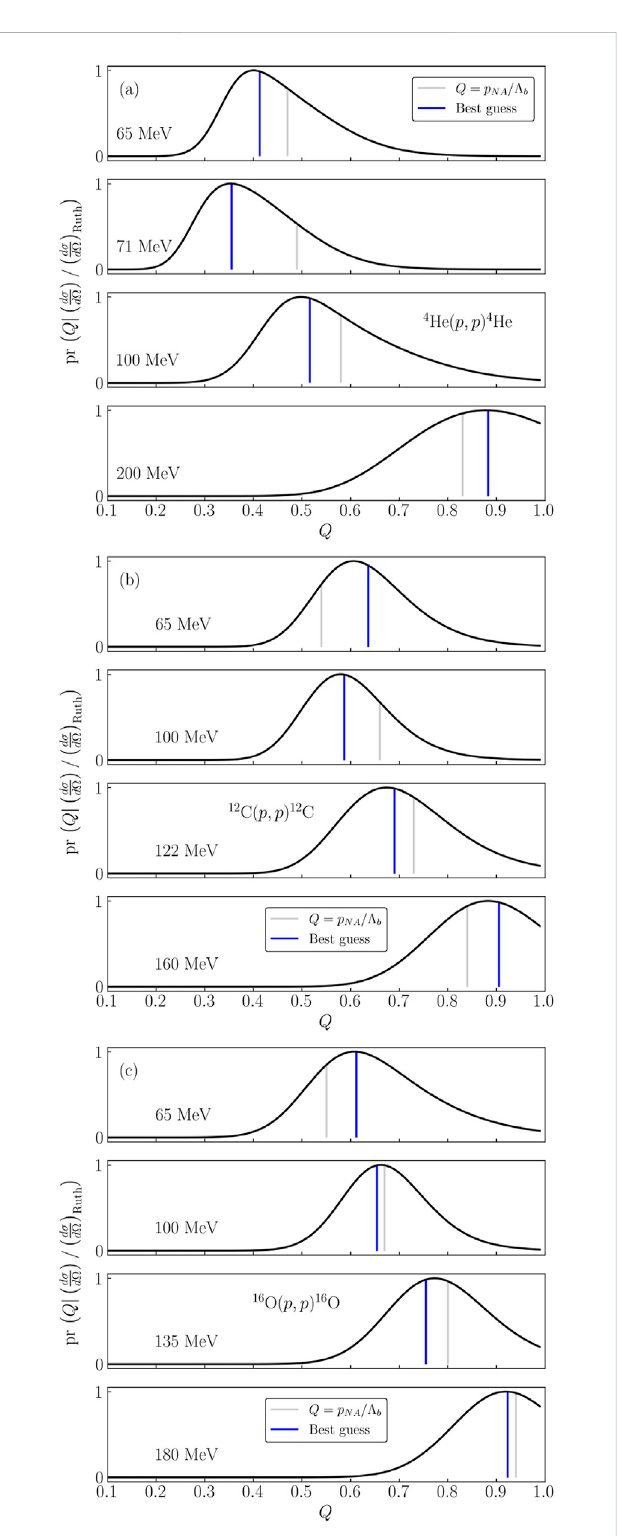
FIGURE 11 Posterior plots for the expansion parameter Q given the differential cross sections for proton scattering on (A) 4 He, (B) 12 C, and (C) 16